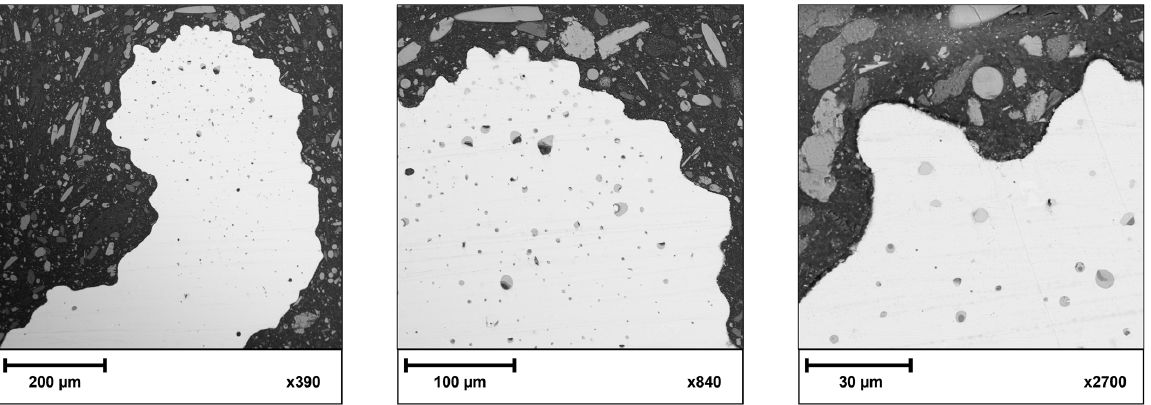
Figure 11. The SEM (PHENOM PRO) images of the internal porosity of the strun of the Voronoi